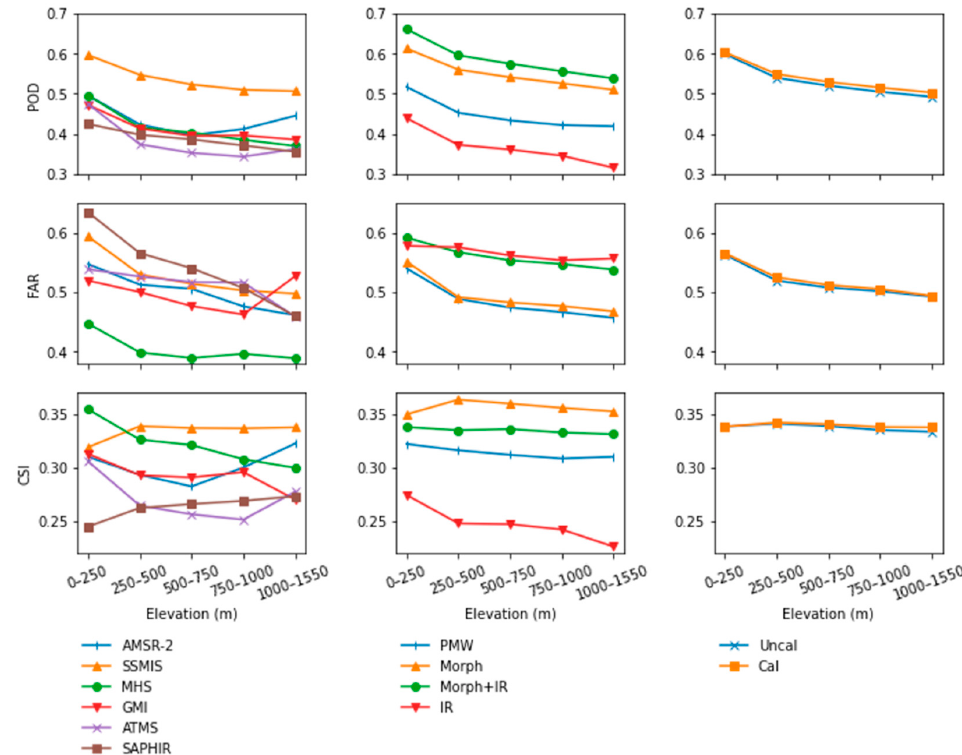
Figure 6. Three categorical indices, higher probability of detection (POD), false alert ratio (FAR), and critical successful index (CSI), for 12 IMERG estimates according to different elevation bands. The left column indicates six individual PMW estimates, and the middle column demonstrates four multi-satellite estimates for the second level of evaluation, among the merged PWM, morphed PWM, the mixture of morphed PMW and IR, and IR-only estimates, and finally, the right column shows the multi-satellite estimates with and without gauge calibration.